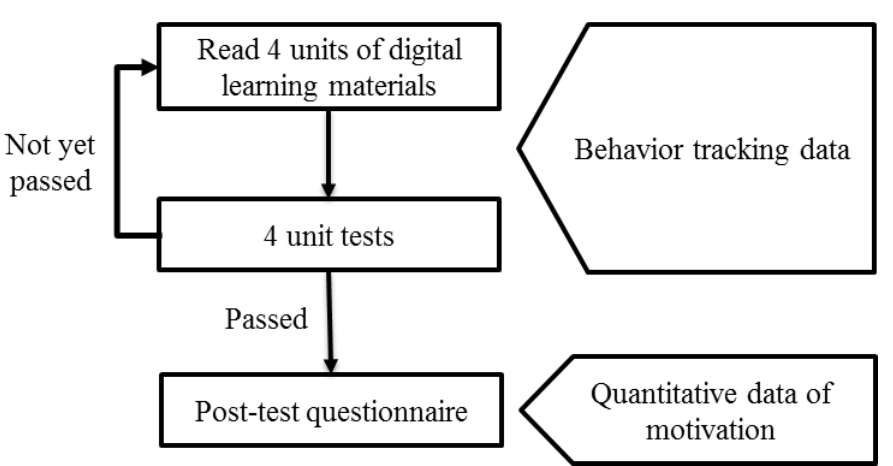
Figure 1. Experimental design.